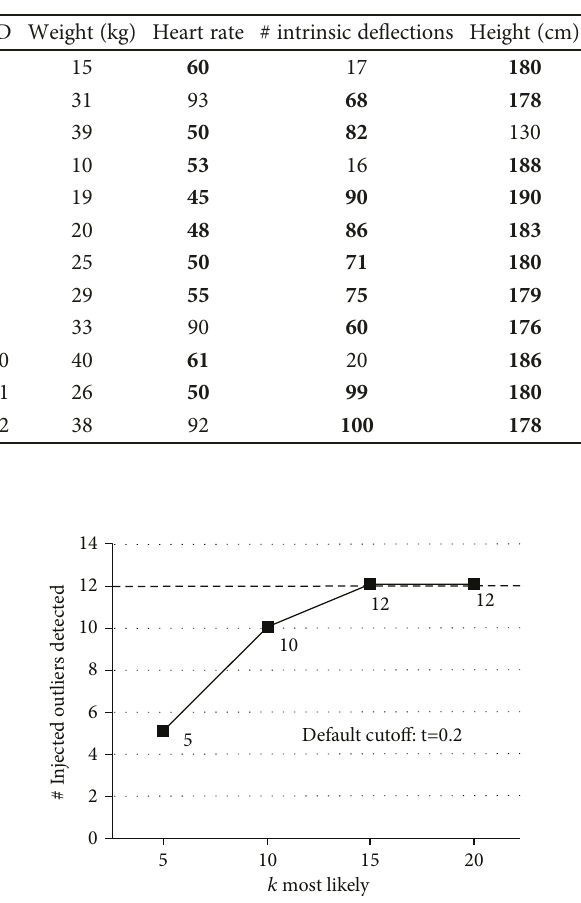
Table 2: Outliers injected into the test